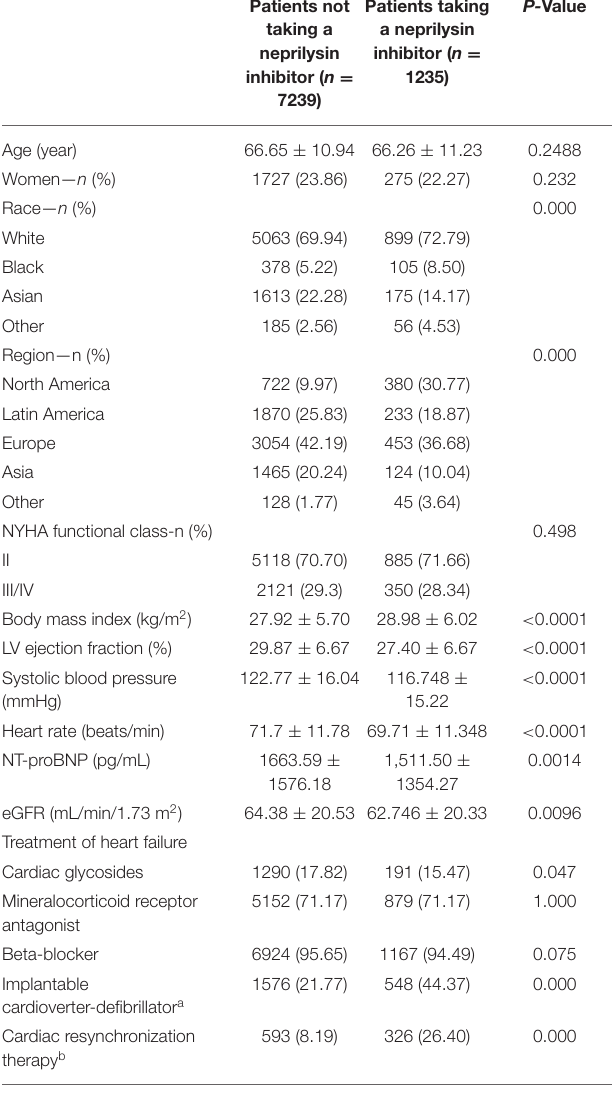
TABLE 1 | Baseline characteristics in patients taking and not taking a neprilysin inhibitor.